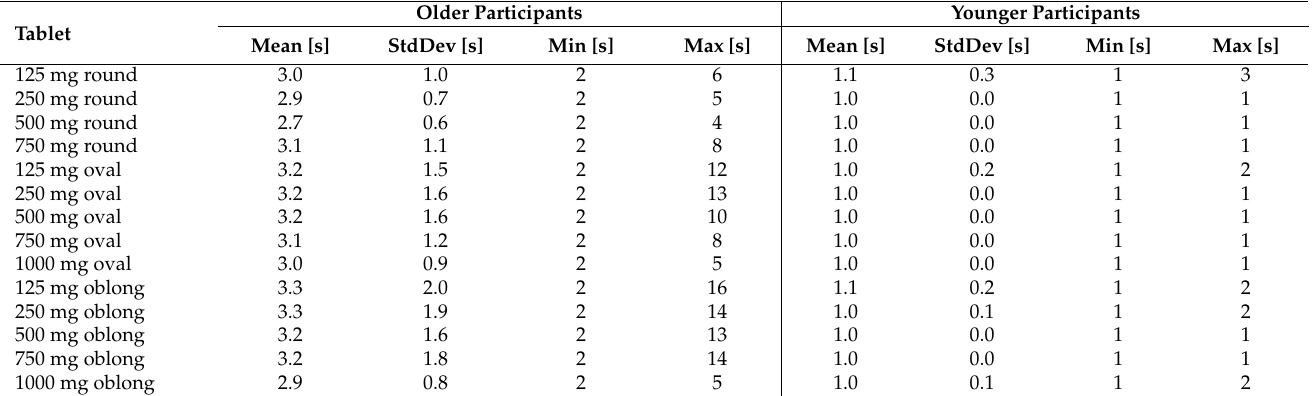
Table 4. Time needed to handle the different tablets. Data are given for older participants ( left ) and younger participants ( right ).